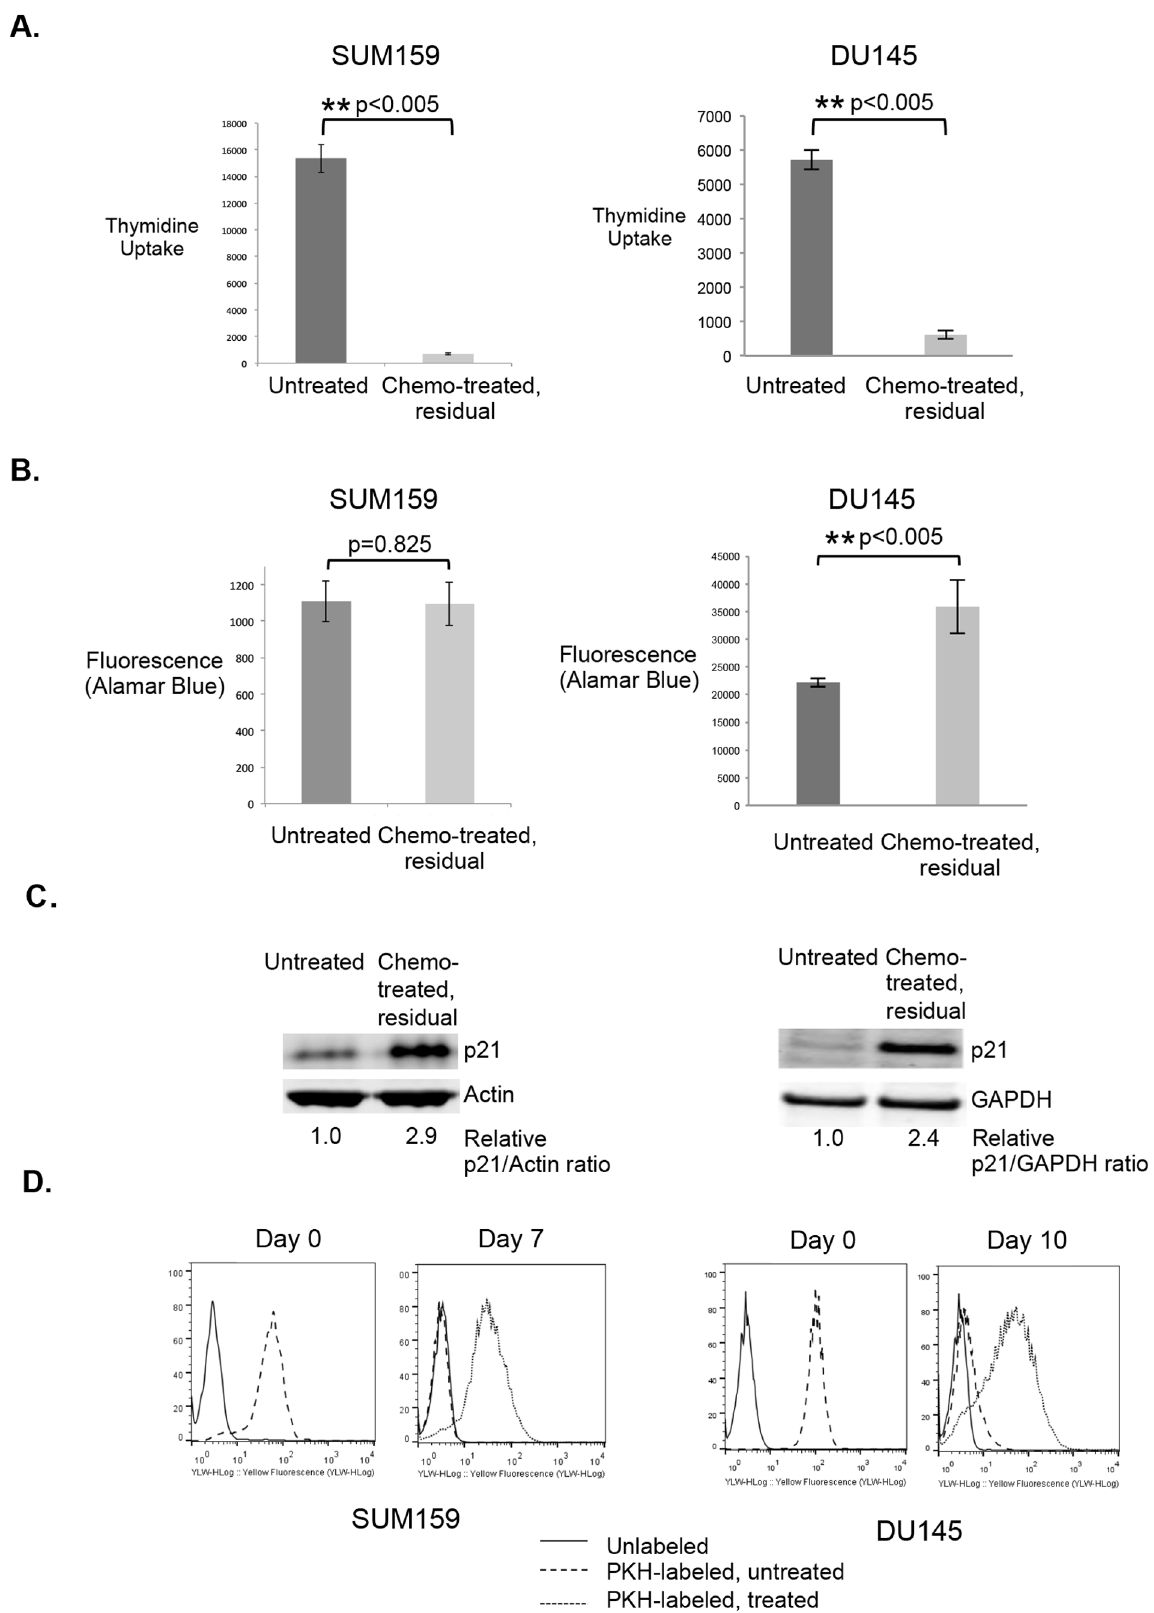
Figure 2. Chemotherapy enriches for dormant tumor cells. A and B. SUM159 breast and DU145 prostate cancer cells were exposed to acute Doxorubicin or Docetaxel treatment, respectively (as described in Fig. 1). Residual tumor cells surviving short-term chemotherapy treatment were